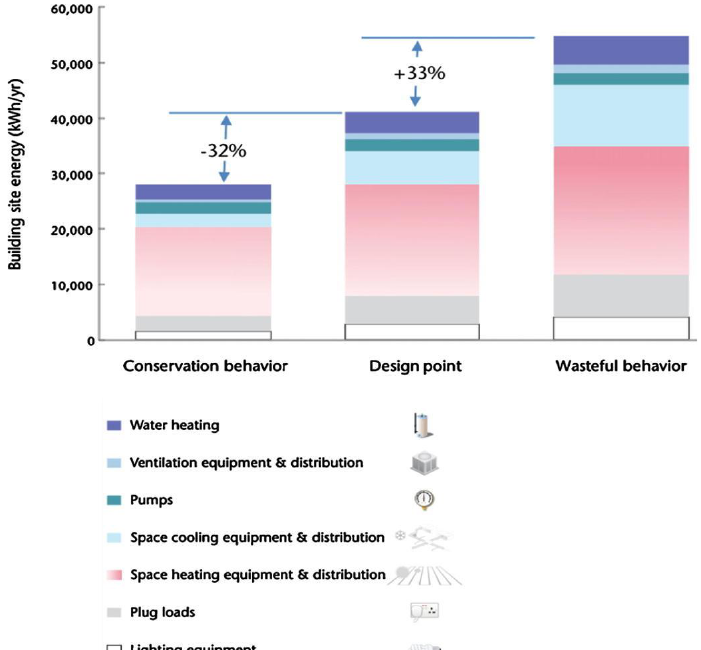
Figure 1: Unwise behavior regarding energy usage doubles the amount of energy as the minimum that can be achieved. (Source: